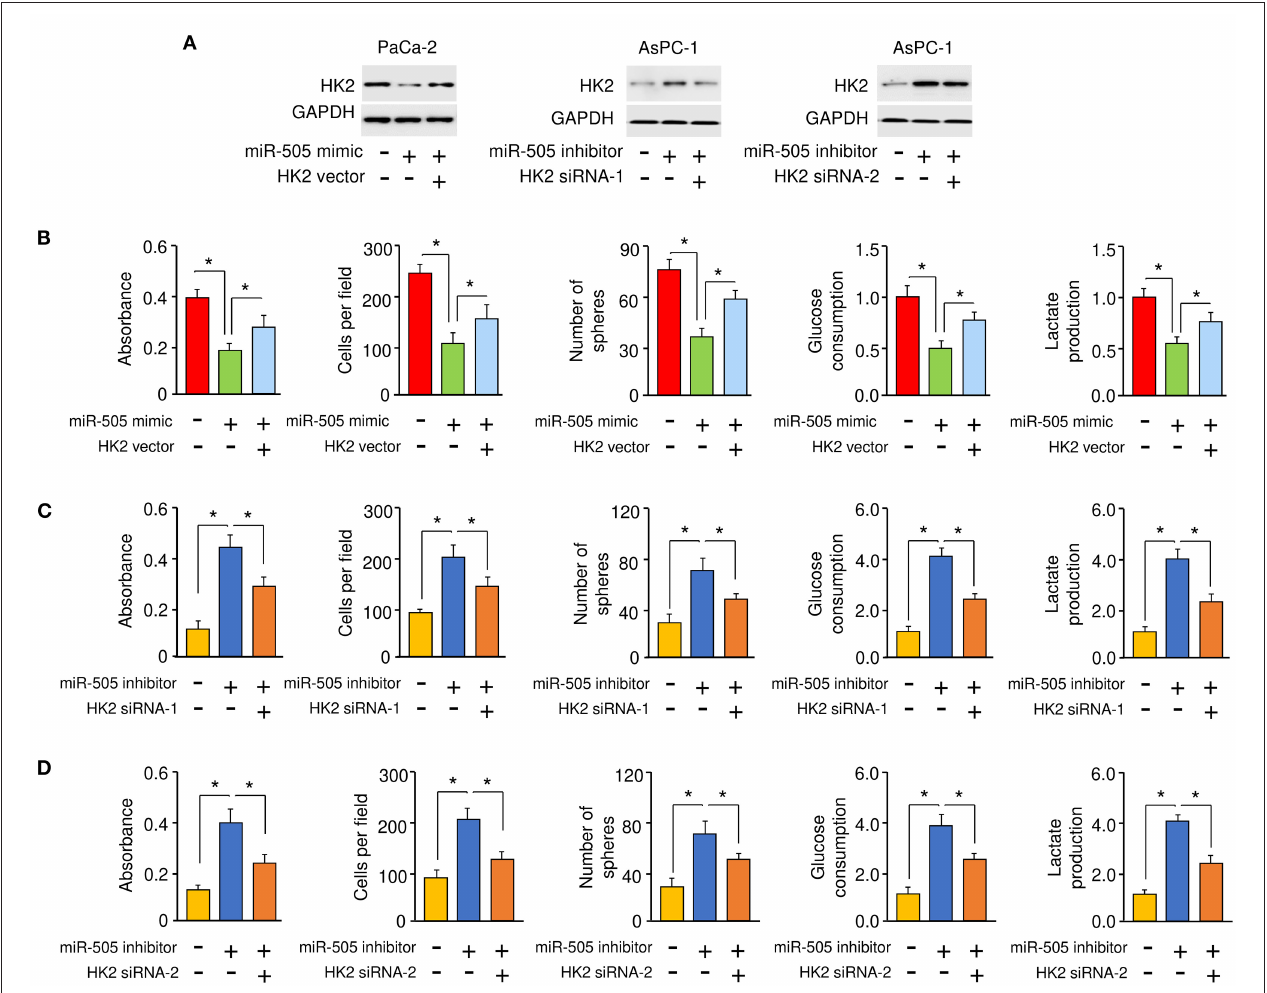
FIGURE 5 | miR-505 acts as a tumor suppressor by inhibiting HK2 expression in PC cells. (A) Western blotting analysis of HK2 expression in PaCa-2 cells transfected with or without miR-505 mimic, together with (or without) HK2 vector, or in AsPC-1 cells transfected with or without miR-505 inhibitor, together with (or without) HK2 siRNAs. (B) Cell functional assays were conducted in PaCa-2 cells transfected with (or without) miR-505 mimic, along with (or without) HK2 expression vector. (C,D) Cell functional assays were done in AsPC-1 cells transfected with (or without) miR-505 inhibitor, together with (or without) HK2 siRNA-1 (C) or HK2 siRNA-2 (D) . * P <